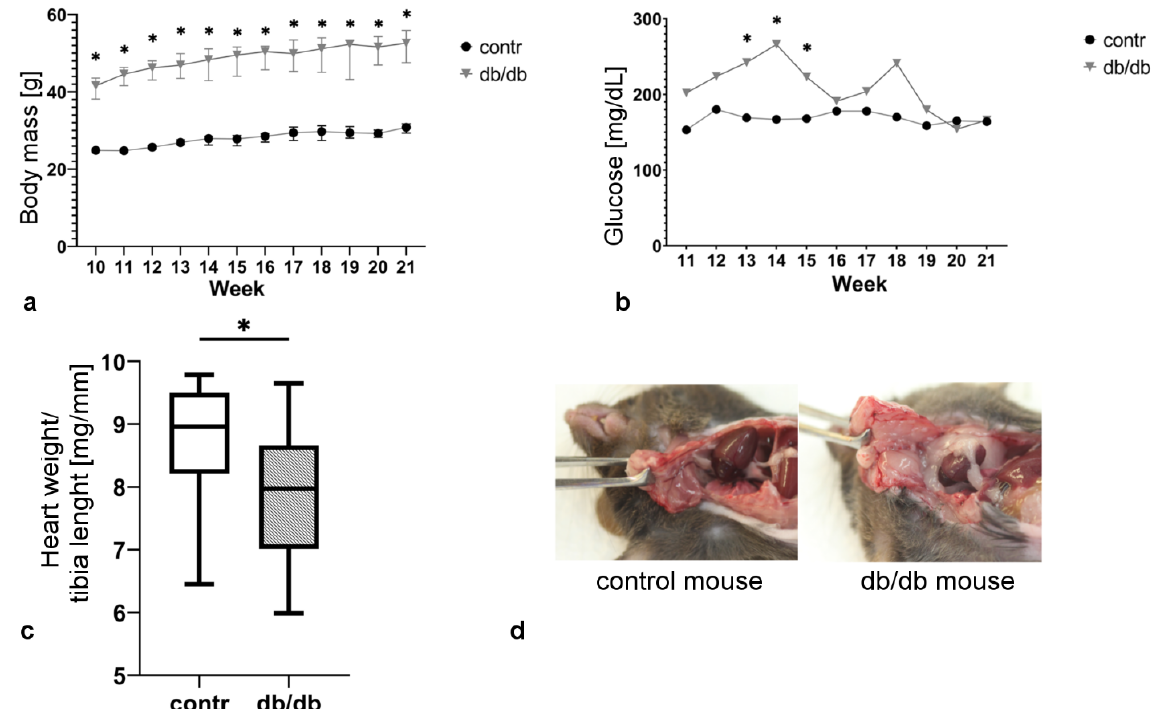
Figure 1. The development of MetS symptoms in db/db mice. ( a ) body weight gain; ( b ) blood glucose level; ( c ) normalized heart weight; ( d ) pericardial adipose tissue in control and db/db mice. Values are mean ± S.E. ( n = 6); *, p < 0.05 versus control group as determined by Wilcoxon signed-rank test.